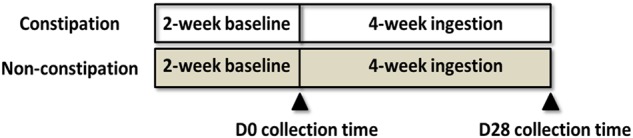
Human study design.